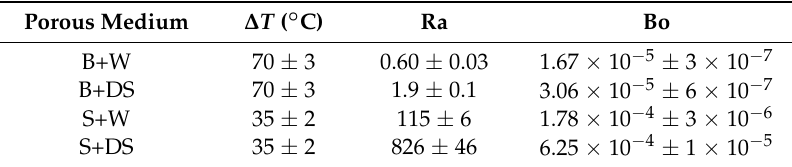
Table 4. Rayleigh and Bond number of each porous medium.